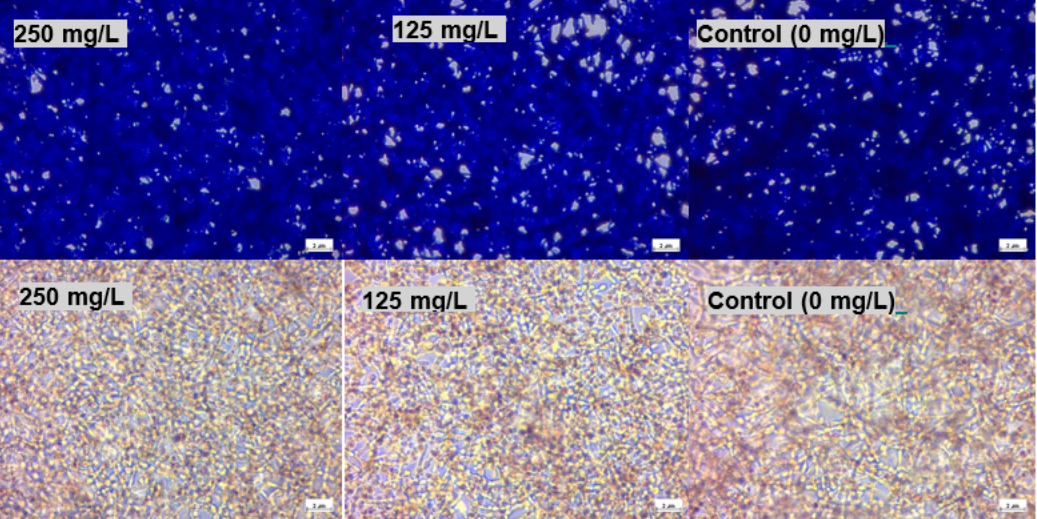
Figure 5. Images of C. albicans biofilm 24-h treated with thymol and stained with crystal violet assay ( top row) and neutral red assay ( bottom row) (×400).